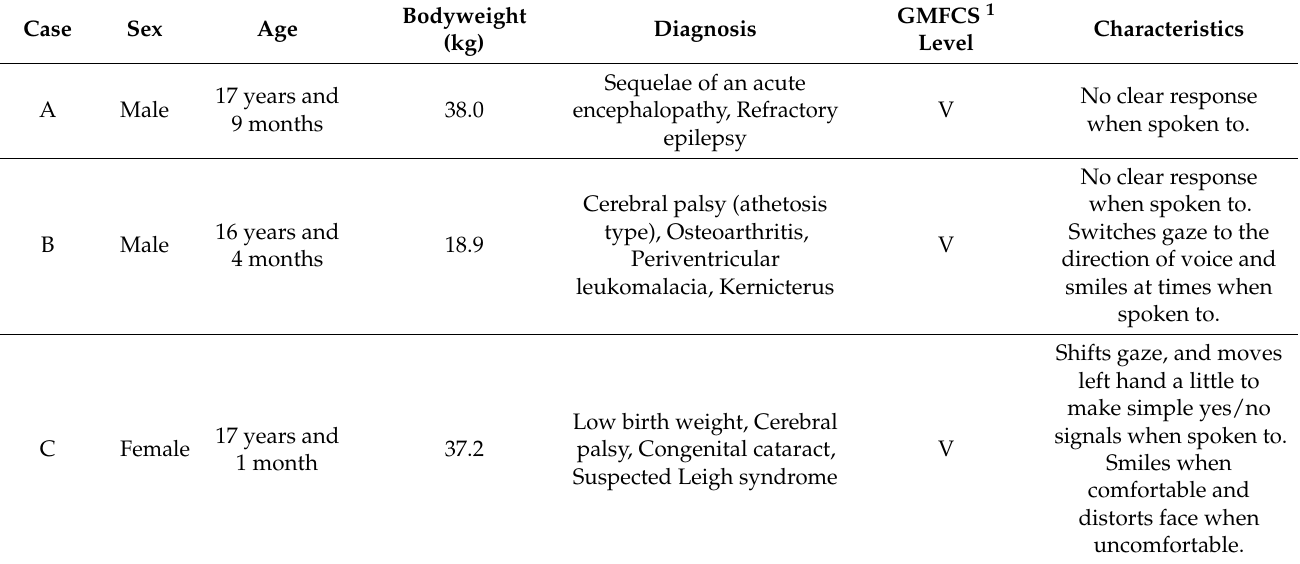
Table 1. Basic information concerning the participating